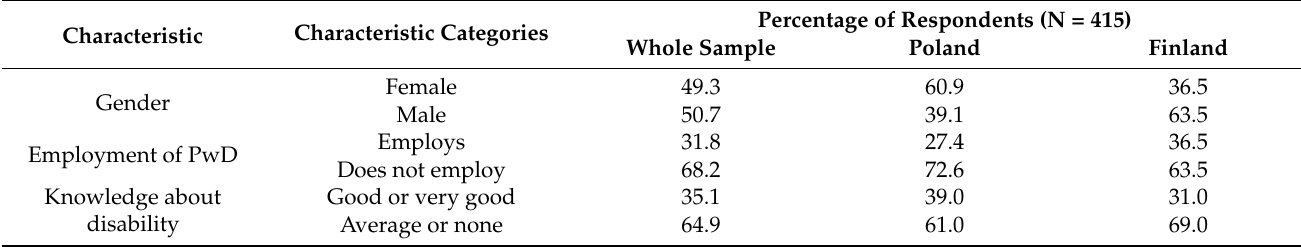
Table 2. Sample structure in the CAWI